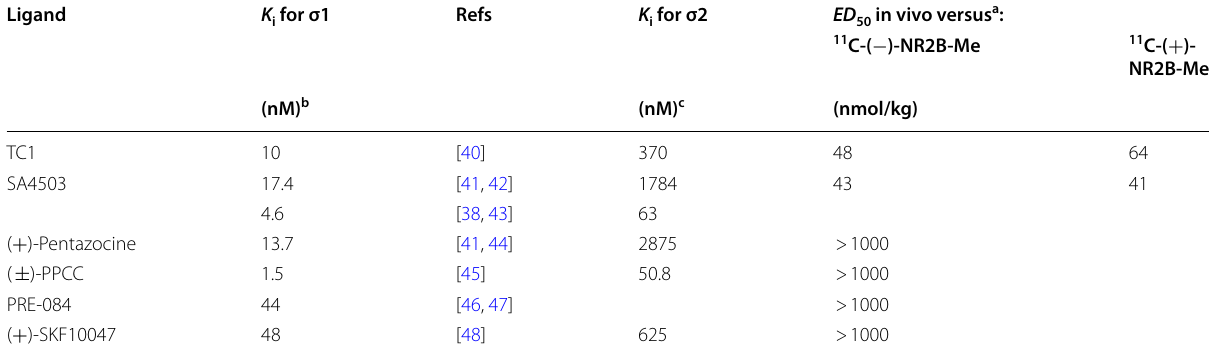
a In rat whole brain